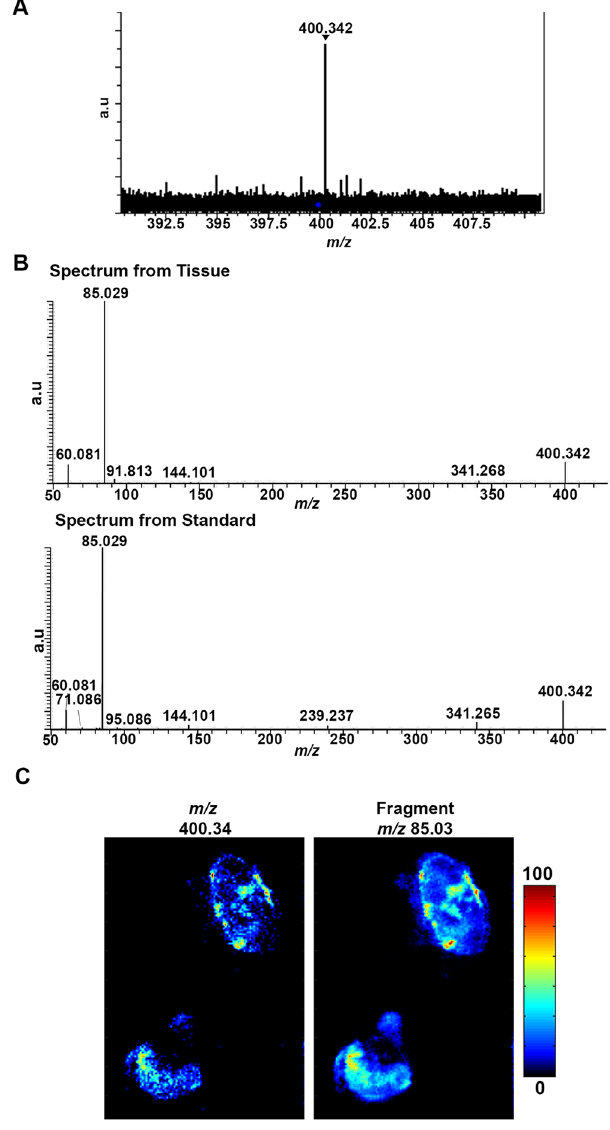
Figure 2. The biomarker at m/z 400.3 was fully identified as palmitoylcarnitine (PalC). ( A ) Mass spectrum from MALDI-FTICR-MS showing the accurate mass of the biomarker at 400.3 (400.342). ( B ) A mass spectrum from the on tissue fragmentation of the molecule at m/z 400.3 and from the fragmentation of the standard by DESI-Orbitrap-MSI showing the similar fragmentation pattern. ( C ) Heat map images from DESI-orbitrap- MSI validating identification by showing localisation of parent ion ( m/z 400.34) to the same area as the main fragment from PalC ( m/z 85.03). Colour scale bar shows the colour gradient of the MSI image in relation to relative abundance of the imaged molecule, colour gradient from 0% relative abundance of molecule to 100% relative